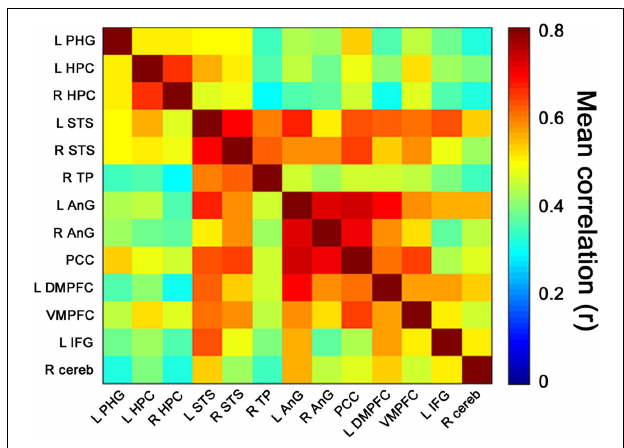
FIGURE 5 | Retrieval-related coactivation in the retrieval network. Functional coactivation matrix depicting correlations between BOLD signal time courses of ROI-pairs for retrieval events. Each cell indicates the group’s mean correlation coeffi cient that was computed between the BOLD signal of a pair of ROIs from the retrieval network depicted in Figure 3 . Mean correlation values are shown at the range of 0 (dark blue) to 0.8 (dark red). In the correlation matrix, the fi rst 3 regions from top to bottom and from left to right correspond to medial temporal lobe, regions 4–6 to temporal cortices, regions 7–9 to parietal lobes, regions 10–12 to prefrontal cortices, and region 13 to right cerebellum. The cells depicted in the diagonal of each matrix correspond to correlations between activation of each region and itself. Abbreviations here and below: L = left, R = right, PHG = parahippocampal gyrus, HPC = hippocampal complex, STS = superior temporal sulcus, TP = temporal pole, AnG = angular gyrus, PCC = posterior cingulate cortex, DMPFC = dorsomedial prefrontal cortex, VMPFC = ventromedial prefrontal cortex, IFG = inferior frontal gyrus, cereb =